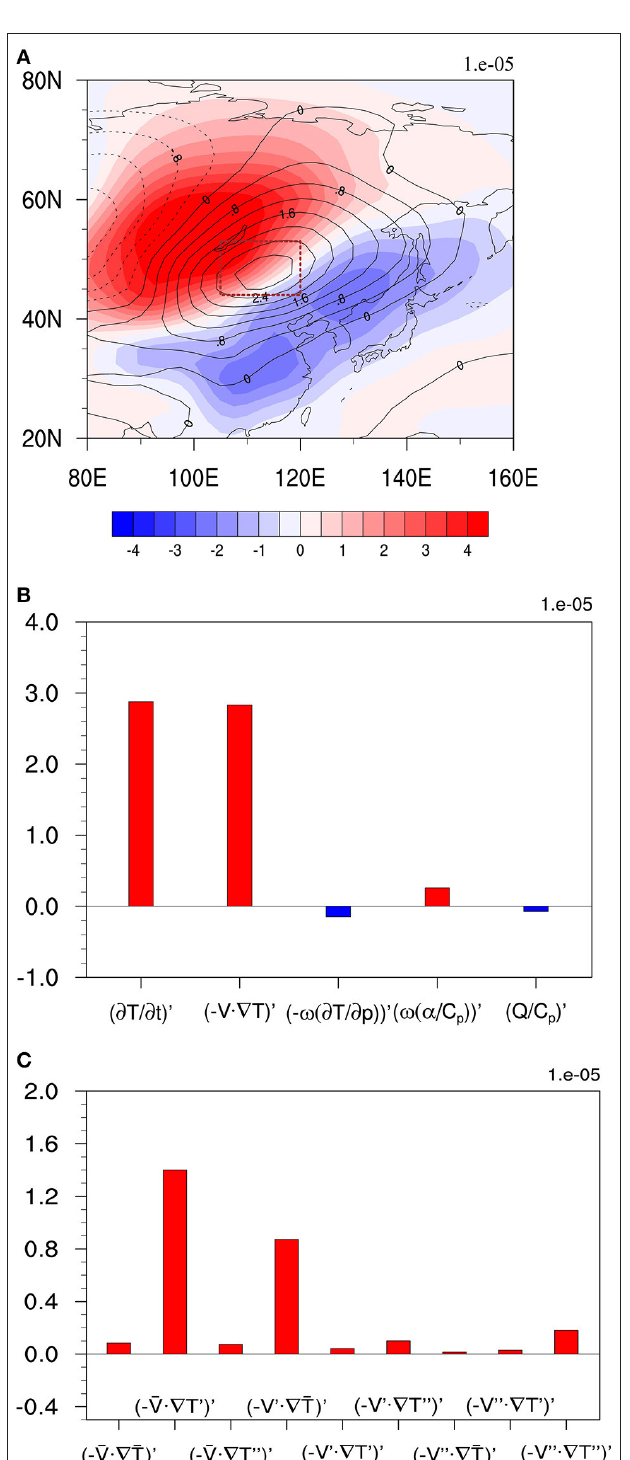
FIGURE 8 | (A) The vertically (1000–700 hPa) integrated intraseasonal temperature anomaly (shading; unit: K) and ∂ T ′ /∂ t (contour; unit: K s − 1 ) at day − 3. A red dotted box (44 ◦ N–53 ◦ N, 105 ◦ E–120 ◦ E) is the key analysis region for ∂ T ′ /∂ t. (B) The temperature budget terms averaged in the red box region at day − 3. (C) Individual components of the anomalous horizontal temperature advection.